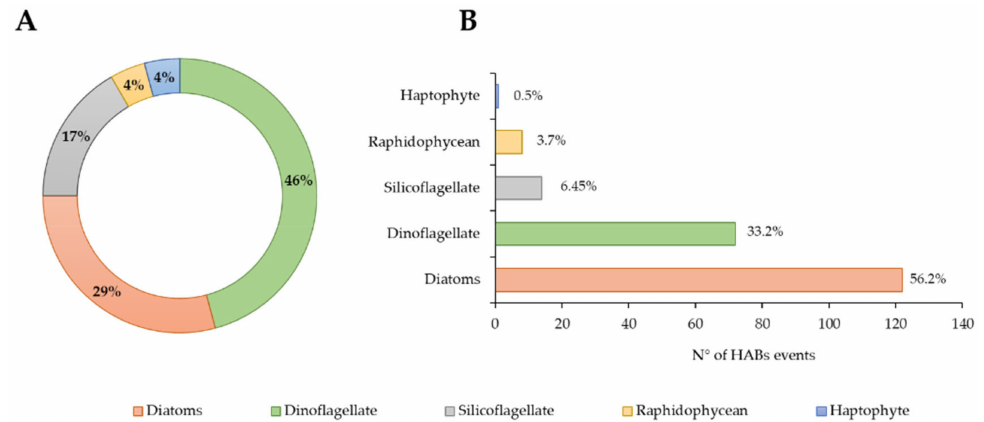
Figure 13. HABs associated with harmful effects on farmed fish and mortality of other marine organisms in Chile, ( A ) distribution of species by group and ( B ) HABs events per group in